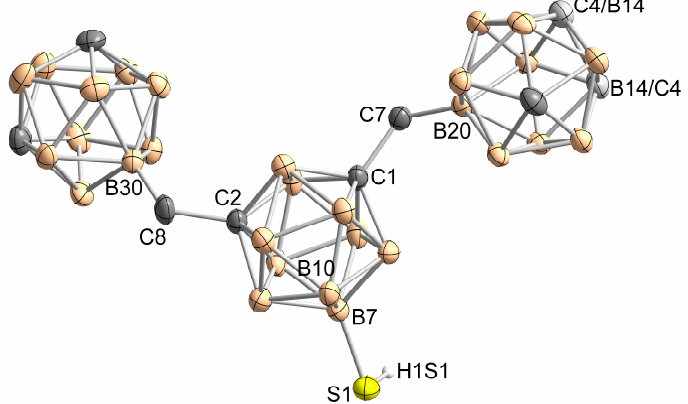
Figure 5. Molecular structure of 1,7-bis(1,7-dicarba- closo -dodecaboran-9-ylmethyl)-1,7-dicarba- closo - dodecaboran-9-ylthiol ( 6 ). Thermal ellipsoids are drawn at the 50% probability level. Carbon/boron disorder in one of the carborane clusters in a ratio of 0.55(2):0.45(2) (shown) and the central carborane unit (ratio of 0.938(1):0.062(1), not shown) is observed. Hydrogen atoms (other than SH) are omitted for clarity. Selected bond lengths [pm] and bond angles [°]: S1 ‒ B7 187.0(4), C1 ‒ C7 152.9(3), C7 ‒ B20